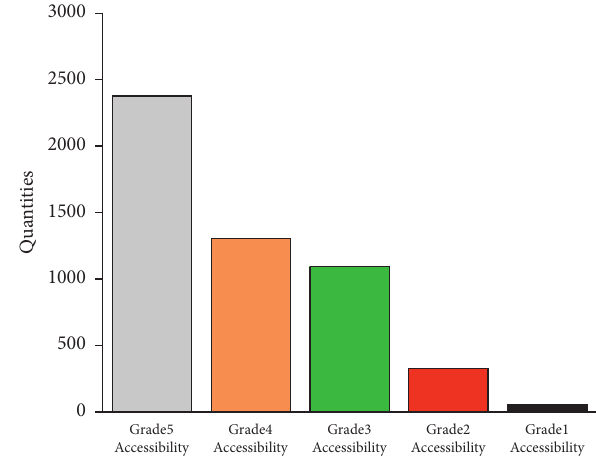
Figure 5: Off-peak accessibility